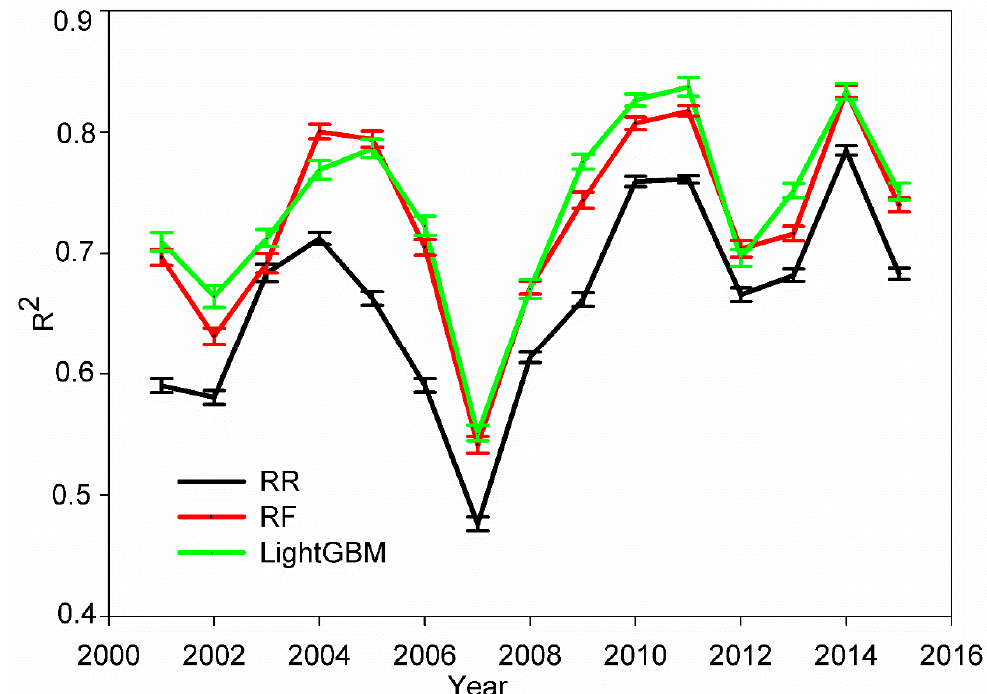
Figure 8. The results of the “leave-one-year-out” experiment across di ff erent years. One-year data are selected for testing, while data from other years for training. The worst performance in 2002 and 2007 may be due to extreme events (black for RR, red for RF, and green for LightGBM model).